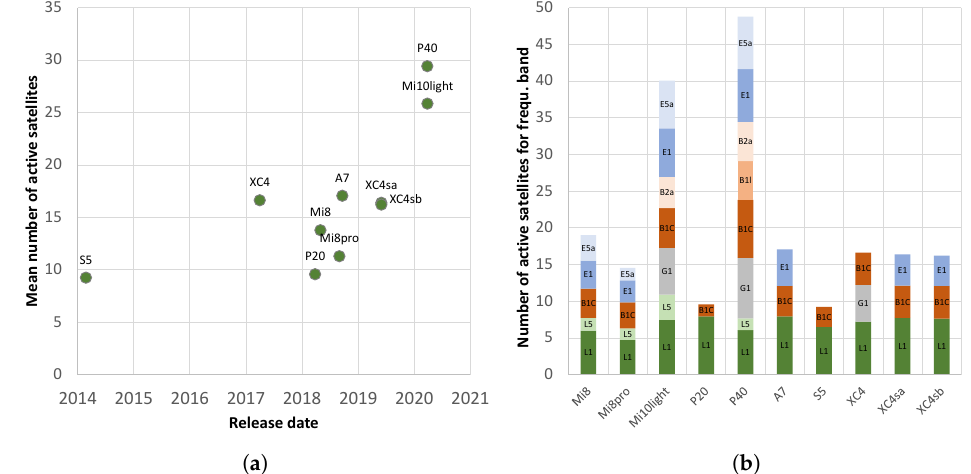
Figure 6. ( a ) Correlation between the release date and the mean number of active satellites used by the smartphones in the whole experiment; ( b ) distribution of active satellites for the different frequency bands (different colors: different frequency